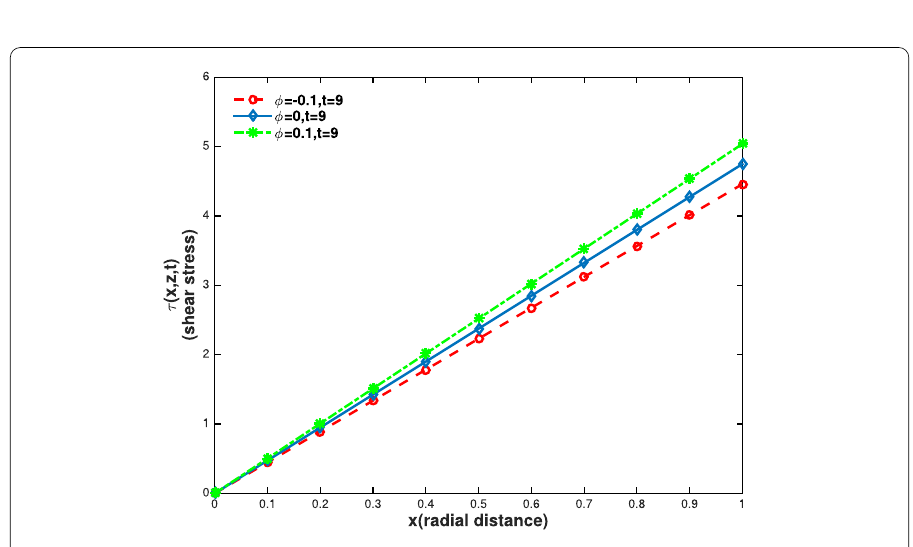
Figure 6 Shear stress vs radial distances for φ = –0.1,0,0.1 at z = 28, t = 9, τ y = 0.4, K =